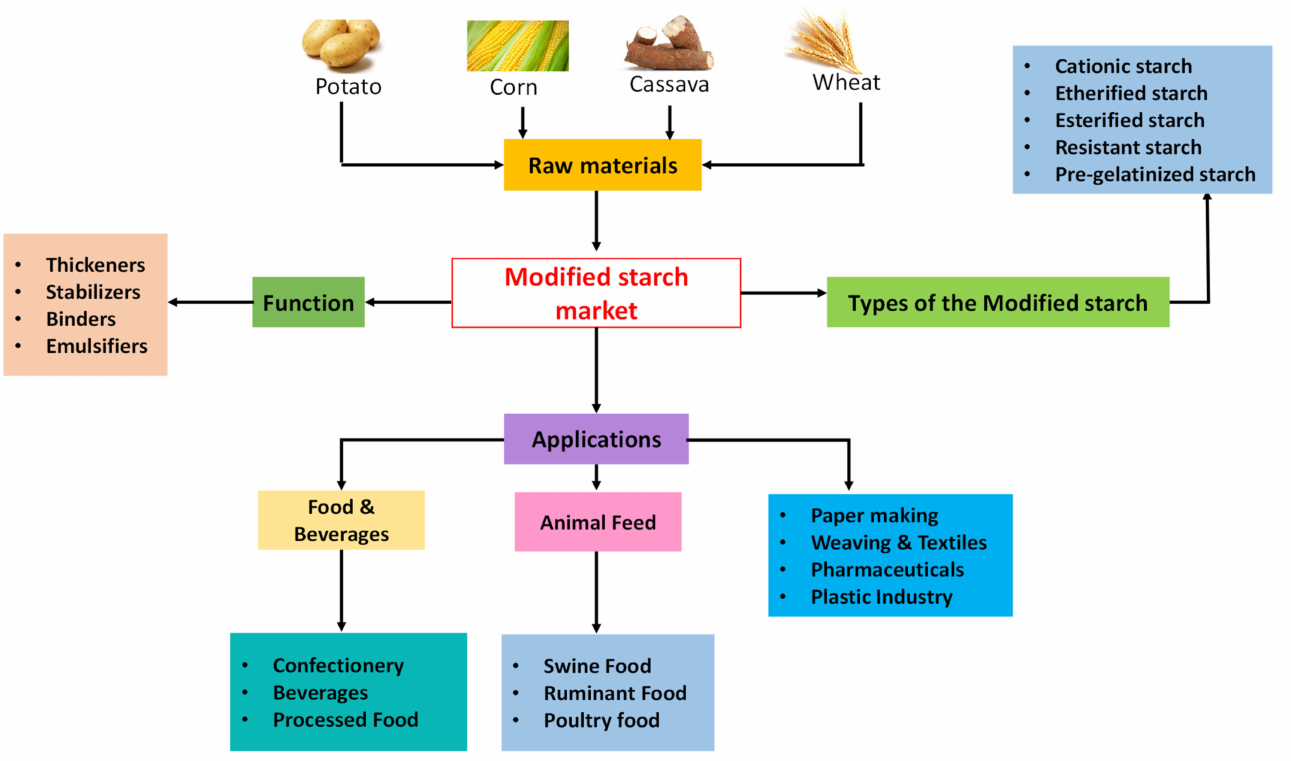
Figure 3. Modified starch market share by the application (Reproduced from: Modified starch market size, by product 2014–2025 (USD billion) Grand View Research, Inc.